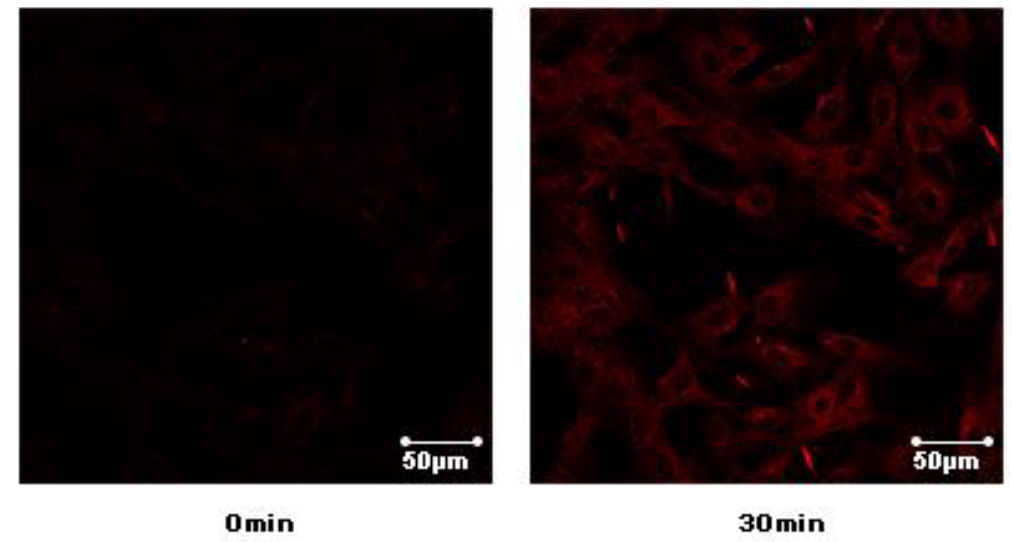
Figure 6. GLUT-4 translocation activities of compounds 1–10 (** p < 0.01, compared with non-treated groups; *** p < 0.001, compared with non-treated group).